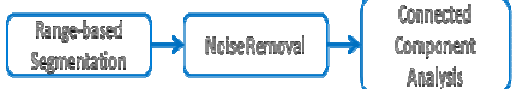
Figure 4: Multiple-step range based segmentation